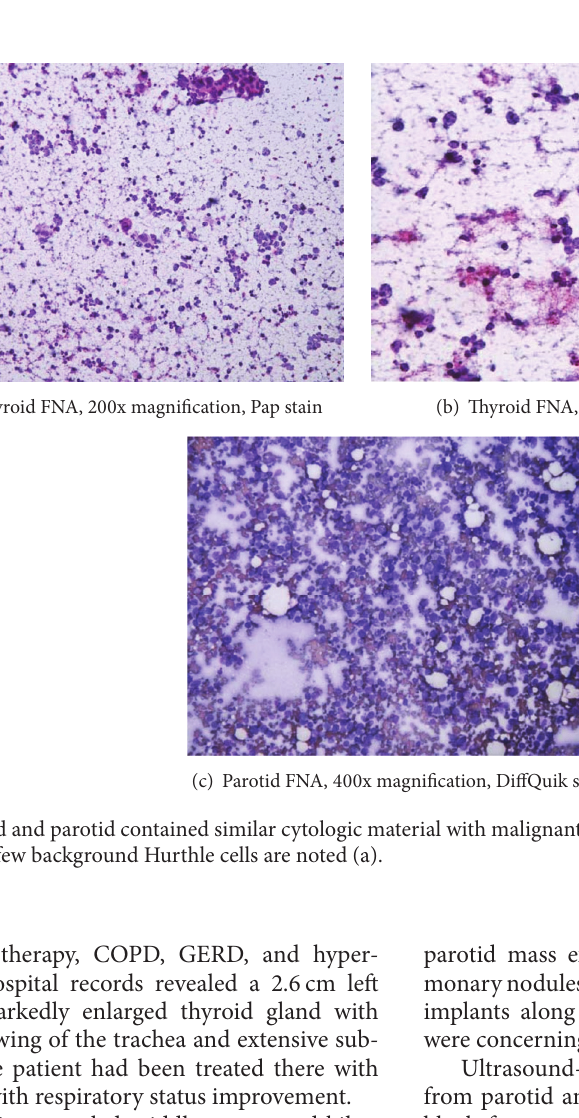
Figure 1: CT images of neck mass (a) demonstrating diffuse thyroid mass with tracheal luminal compression and left parotid mass (b) with central necrosis.